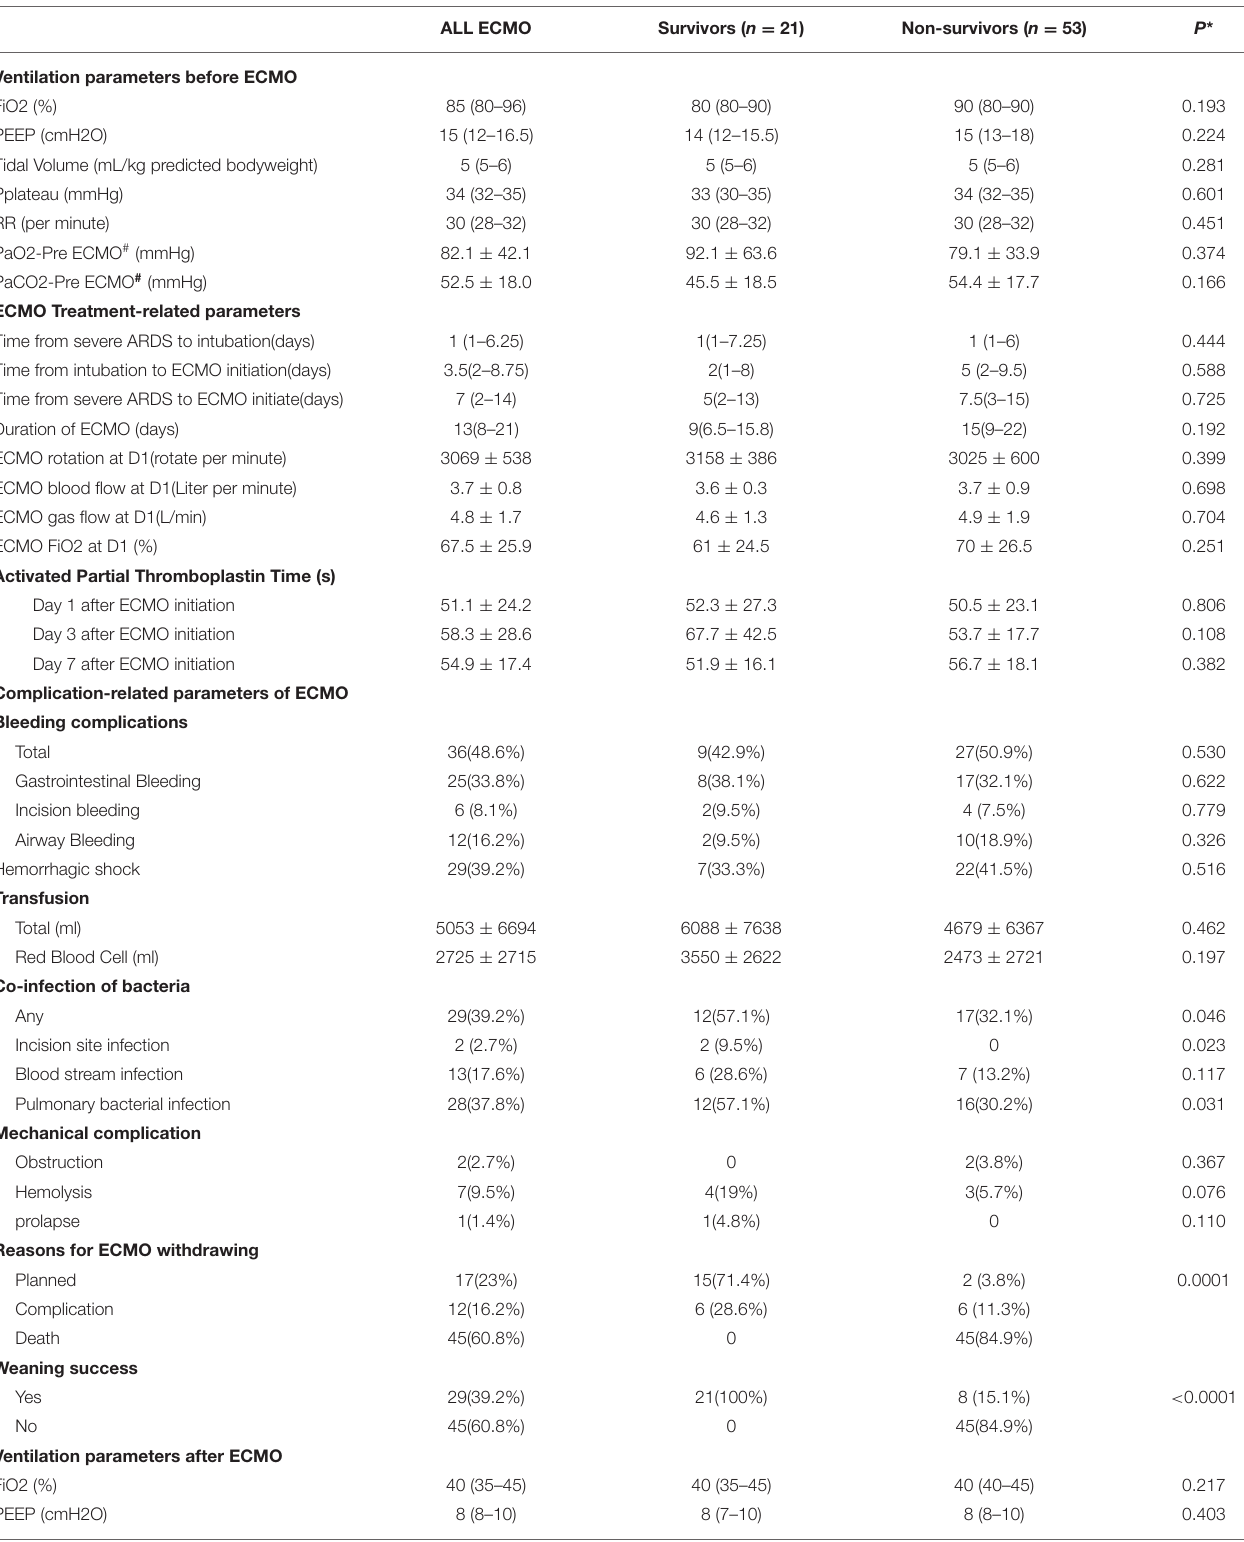
TABLE 3 | Variables associated with ECMO treatment. ALL ECMO Survivors ( n = 21) Non-survivors ( n = 53) P